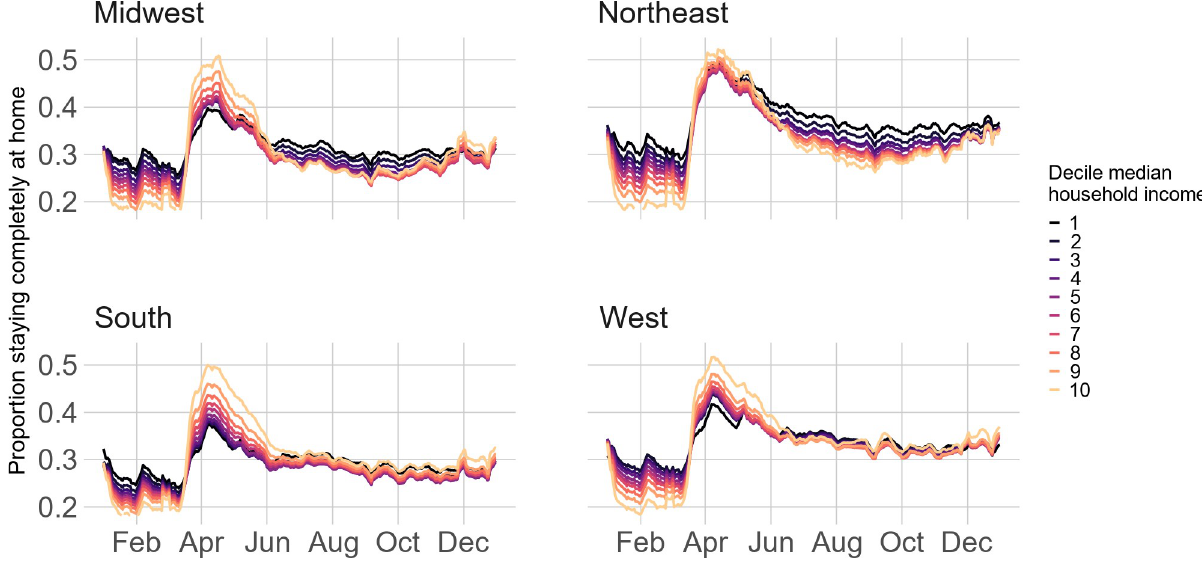
Fig 6. Stay-at-home patterns by income across